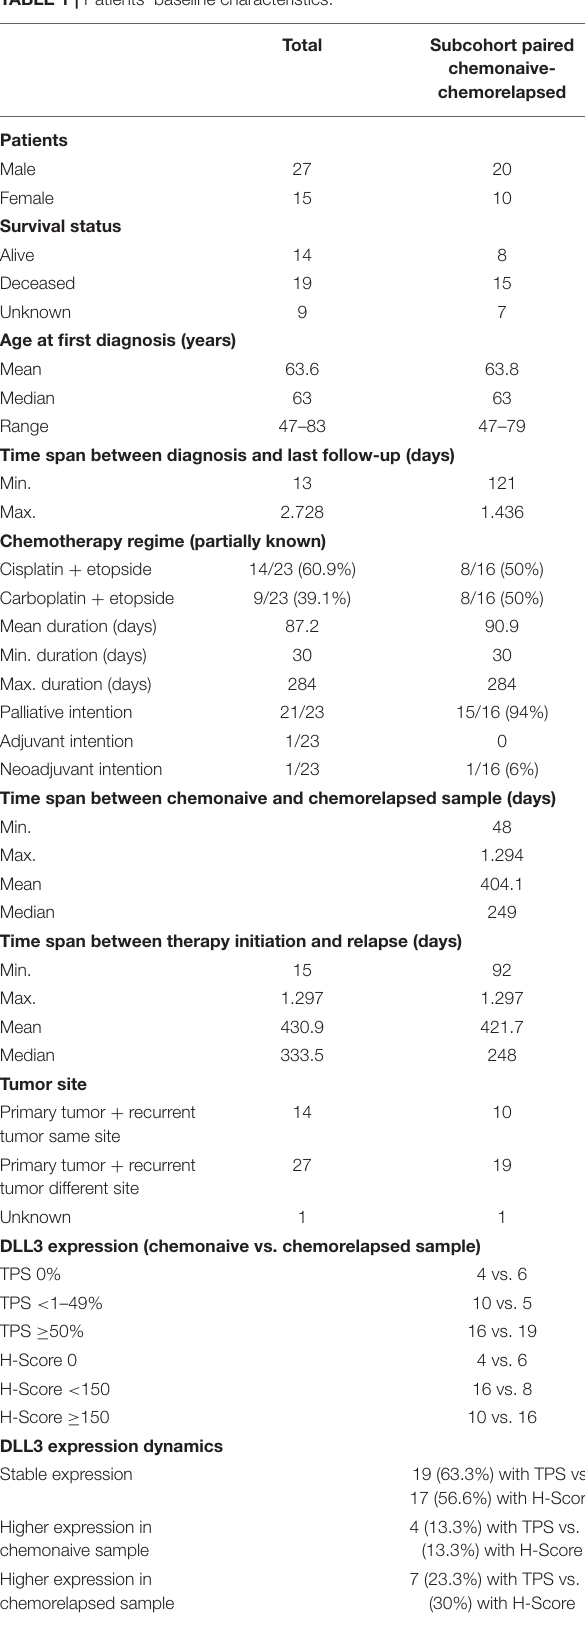
TABLE 1 | Patients’ baseline